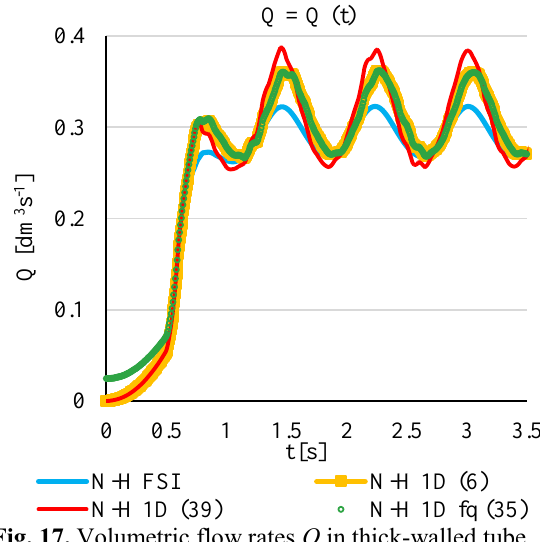
Fig. 17. Volumetric flow rates Q in thick-walled tube.